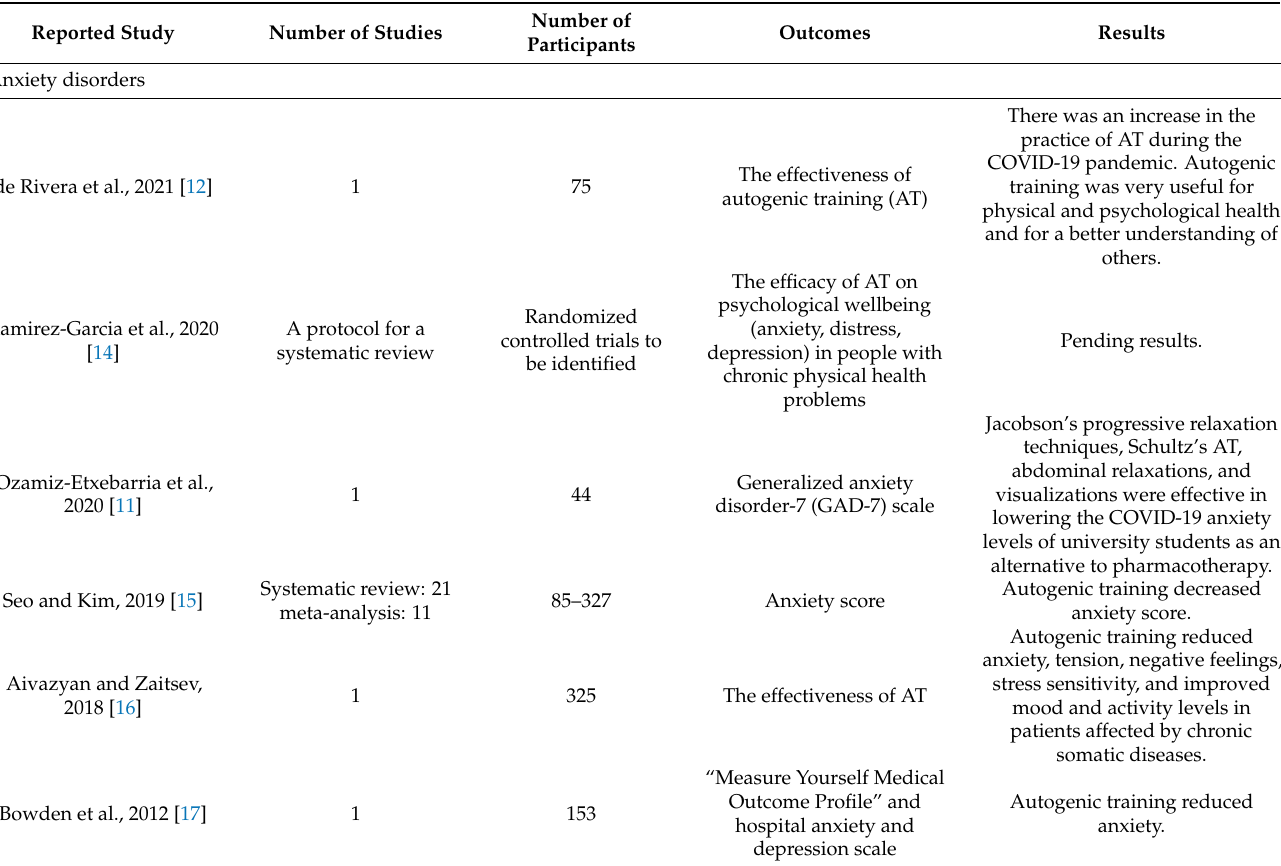
Table 1. Reported studies concerning effects of autogenic training on mental disorders (categorized and sorted chronologically, from most recent to least